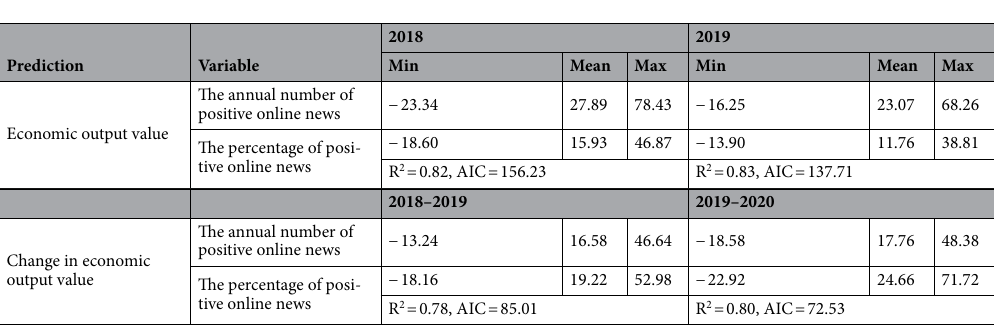
Table 3. GLM estimation results and goodness-of-fit.